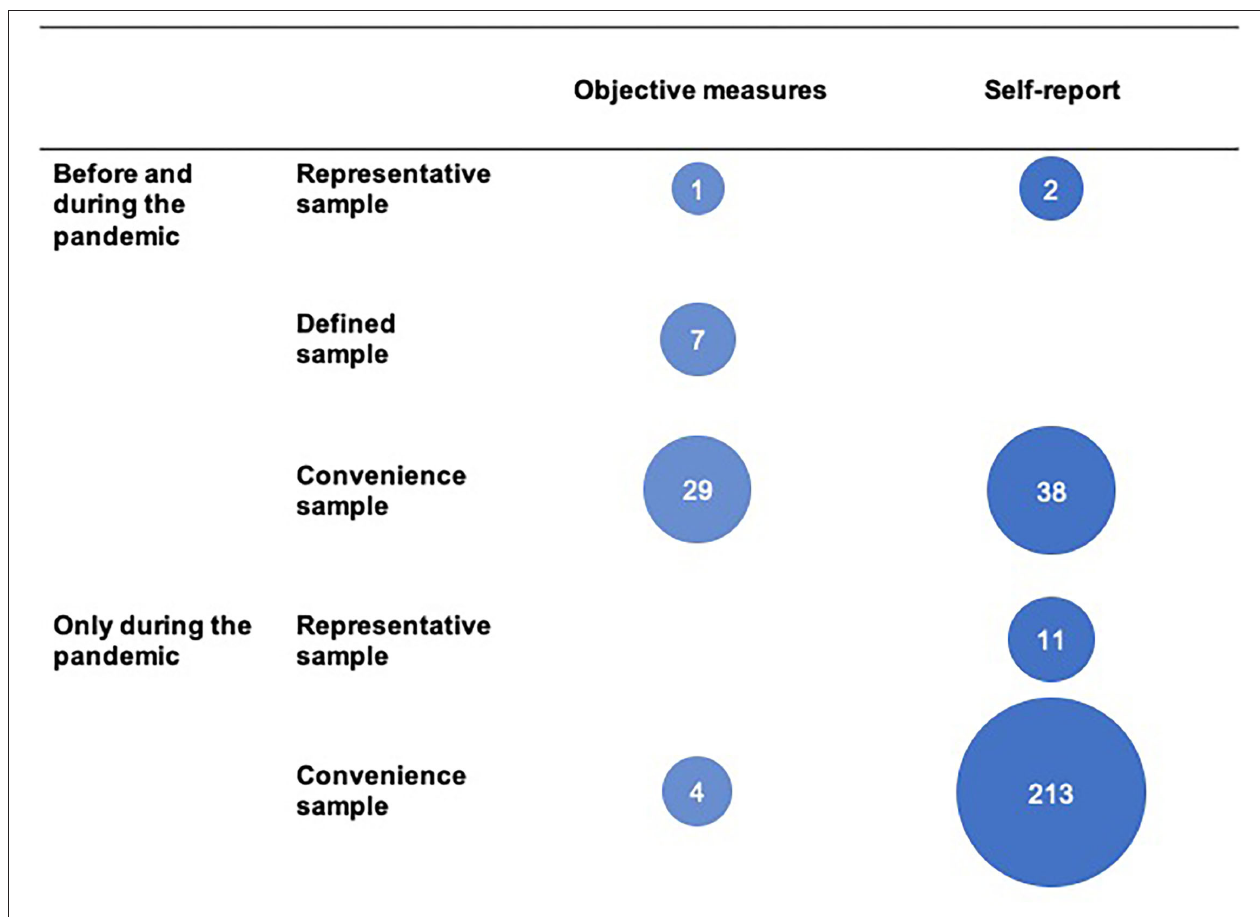
FIGURE 5 | Empirical approaches of the published articles ( n = 305; injury studies not